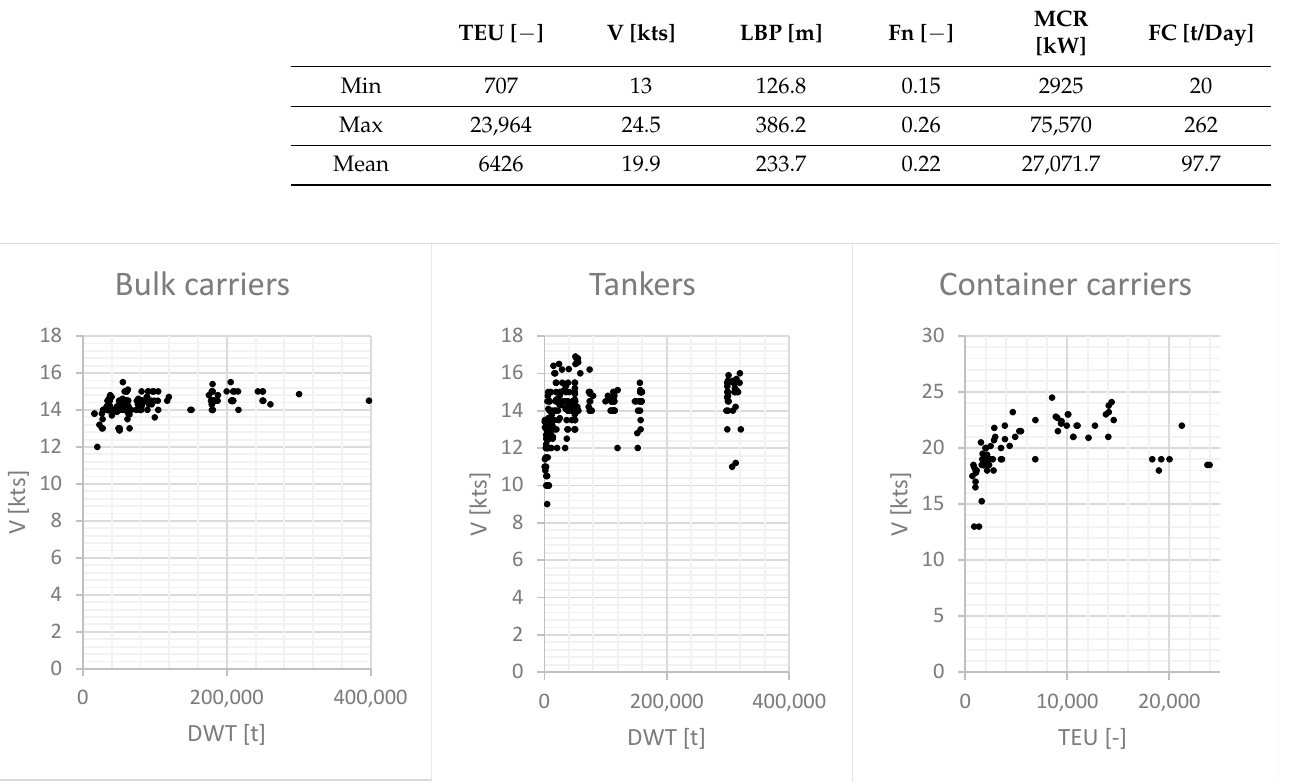
Figure 1. The relationship between velocity V and TEU/DWT capacity of the vessels used in this study. Table 1. Mean, minimum and maximum bulk carrier parameter values, where: MCR—total engine power, FC—daily fuel consumption, DWT—deadweight, V—speed, LBP—length between perpendiculars and Fn—Froude number.